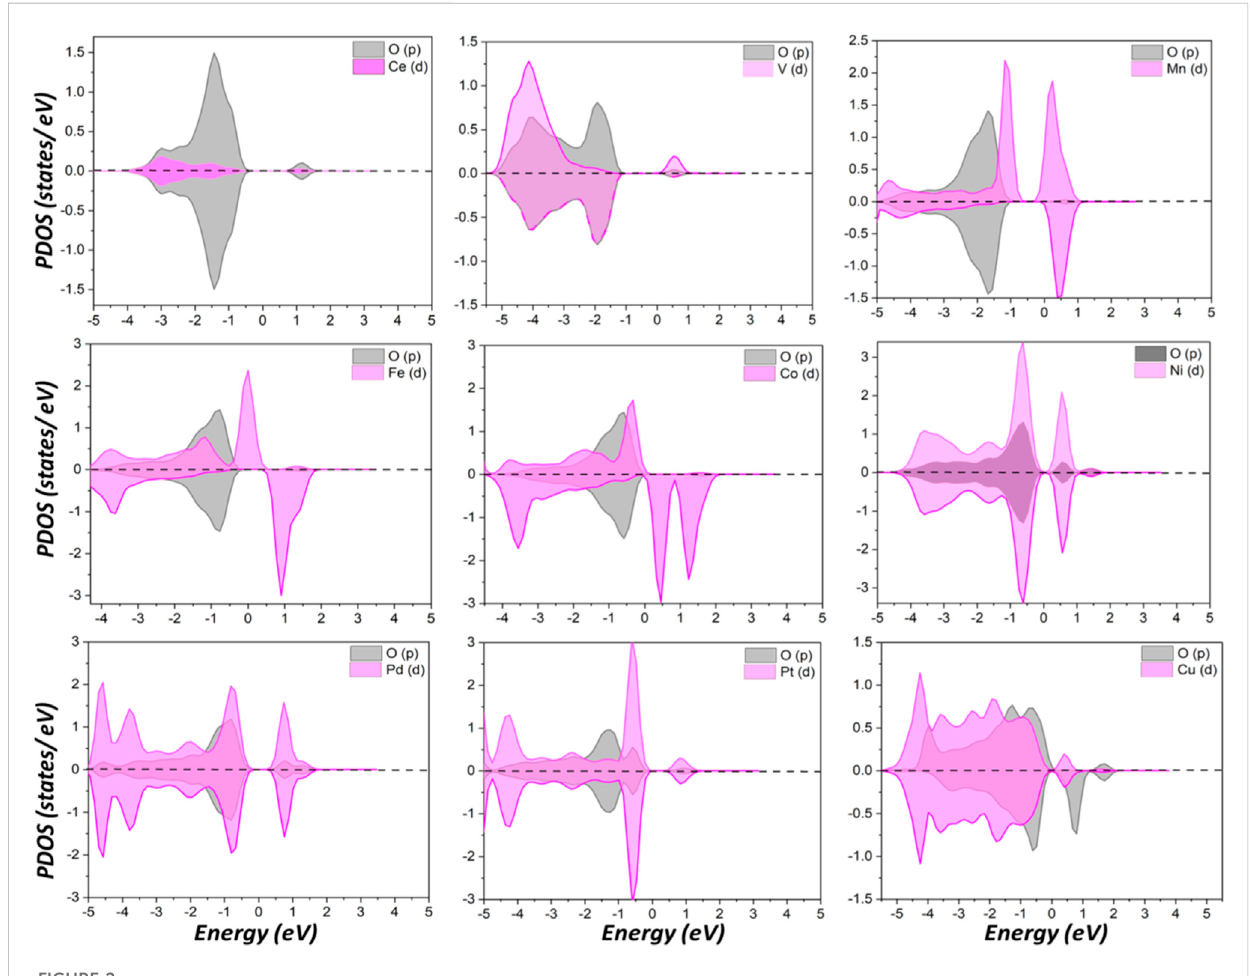
FIGURE 2 Partial density of states (PDOS) of surface oxygen p orbitals and doped metal d orbitals.